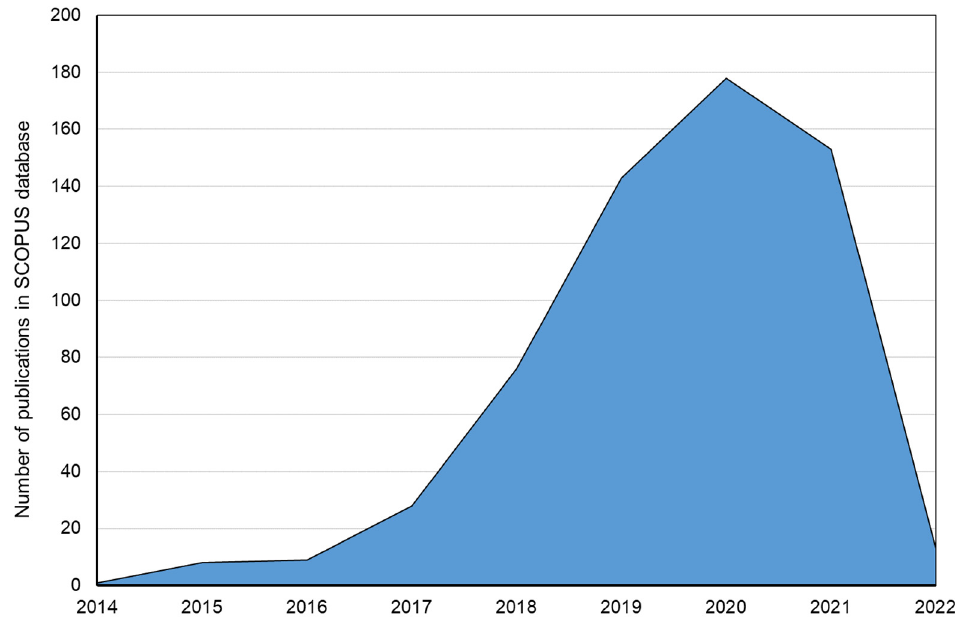
Figure 2. Annual scientific production in the field of Industry 4.0 and SMEs (as of 12 January